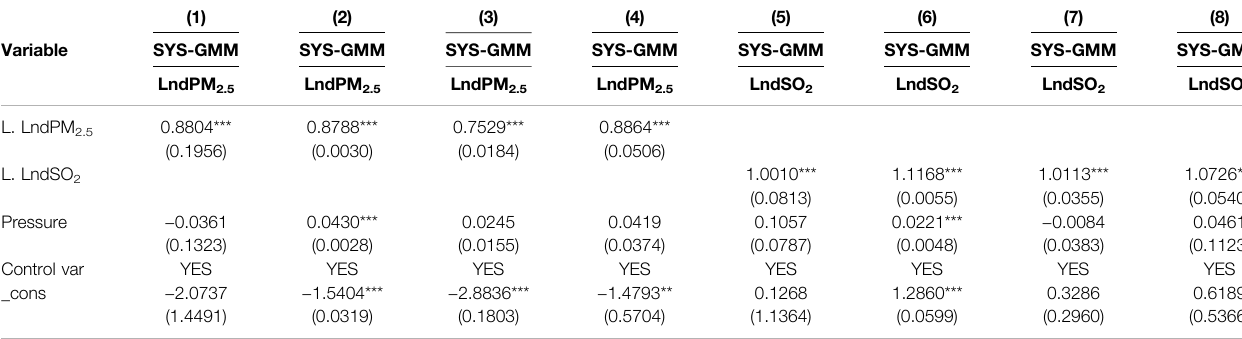
TABLE 5 | Impact of fi nancial pressure on air pollution emissions in different resource-dependent cities.